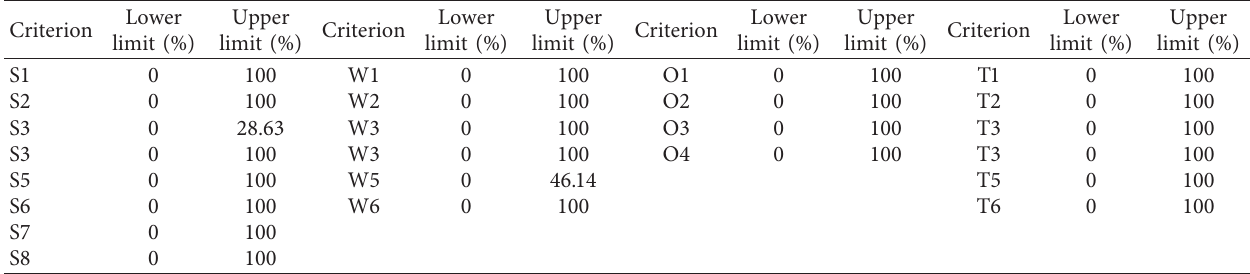
Table 12: Stability